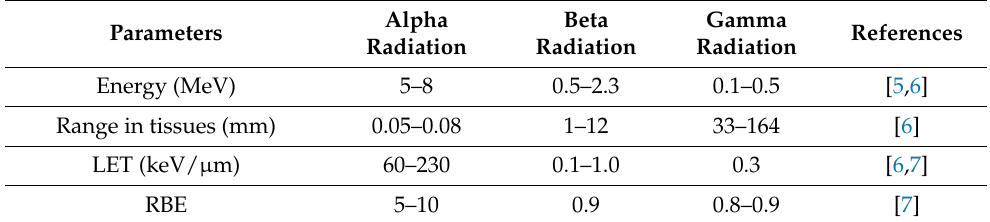
Table 1. Physical and biological characteristics of alpha, beta, and gamma radiation. Parameters